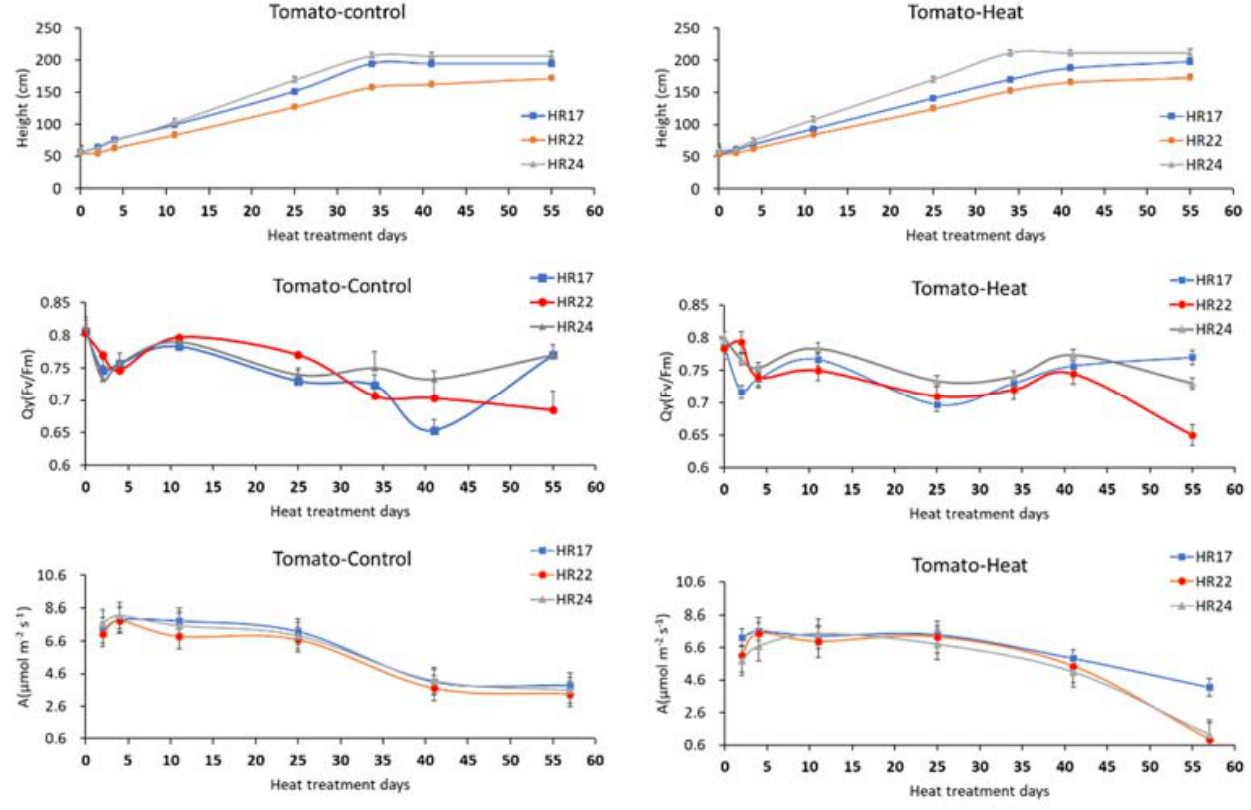
Figure 4. Effects of long-term heat treatment on plant height, the PSII efficiency (Qy, Fv/Fm), net photosynthesis rate (A) of three cherry tomato accessions, HR17, HR22, and HR24, grown in heat-treated and control greenhouses . Table 4. ANOVA of effects of treatment days, heat stress, accessions, and their interactions on plant height, PSII efficiency, photosynthesis rates, and leaf heat damage levels. n.s. indicates no significant difference. * indicates the interaction between variables.